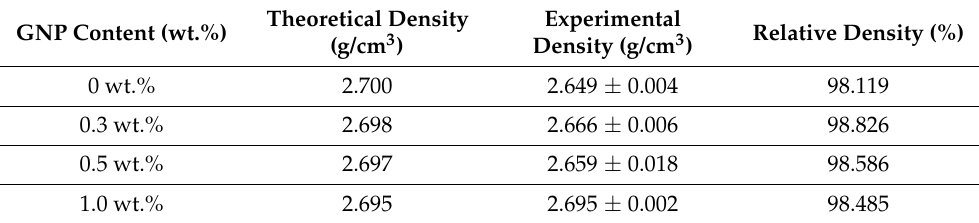
Table 2. Theoretical density, experimental density and relative density of thixoformed Al-GNPs composites. Theoretical Density GNP Content (wt.%) (g/cm 3